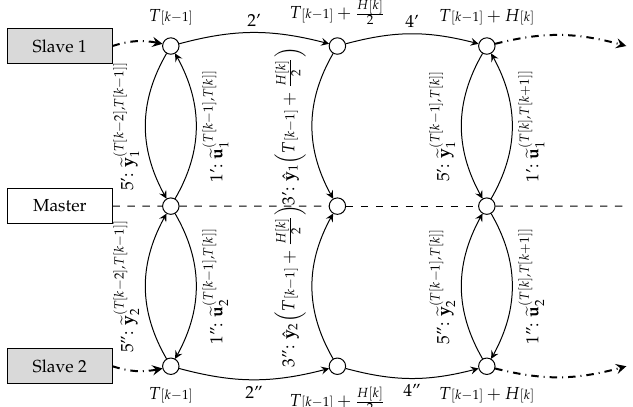
Figure 2. This article uses a non-iterative variant of the Jacobi co-simulation method with variable steps to demonstrate co-simulation defect